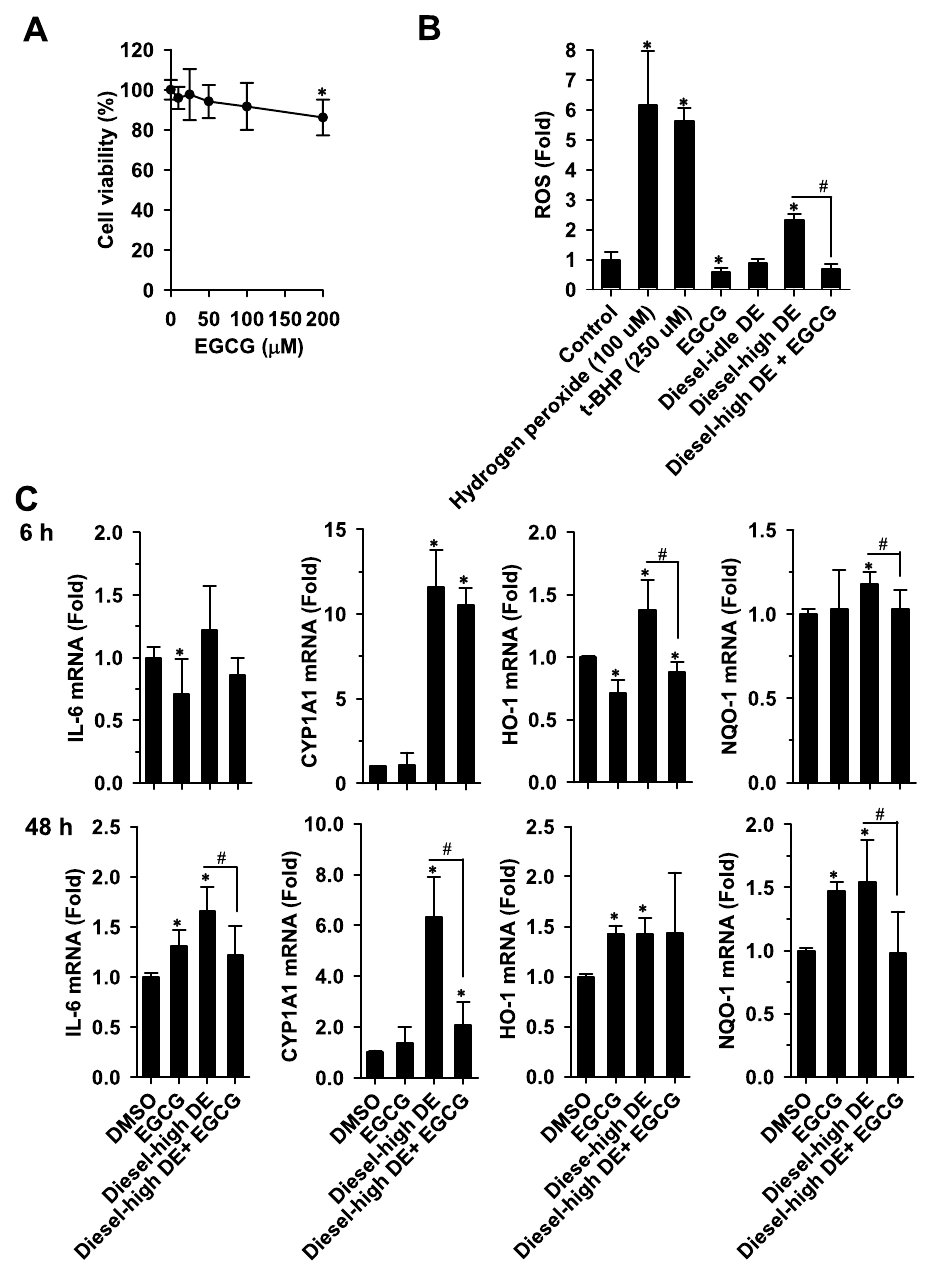
Figure 6. The protective effect of EGCG against the sub-toxic events induced by diesel-high exhaust in A549 cells. ( A ) Effects of EGCG on cell viability. Cells were exposed to increasing concentrations of EGCG for 48 h and cell survival was monitored by MTT assay. Data represent the means ± SD of three different experiments with triplicate determinations in each experiment. * p < 0.05 ( B ) EGCG reduced the cellular reactive oxygen species (ROS)-elevated by diesel exhaust exposure. Cells were exposed to 100 μM EGCG and 10 µg PM 2.5 /ml of the dichloromethane extracts (DEs) of diesel exhausts (alone or in combination). The generation of ROS was determined after 6-h exposure. Hydrogen peroxide and t -butyl hydroperoxide ( t -BHP) were used as the positive exposure for ROS stimulation. ( C ) EGCG suppressed the potent biomarker-induction by DE of diesel- high exhaust. The mRNA levels of the exposure biomarkers were determined in cells exposed to the DE of the diesel-high exhaust with or without the co-exposure to EGCG for 6 and 48 h. In the determinations of ROS and mRNA levels, data represent the means ± SD of three different experiments with duplicate determinations. * p < 0.05 compared to the DMSO exposure; # p < 0.05 compared to the DE of diesel-high exhaust (Student’s t